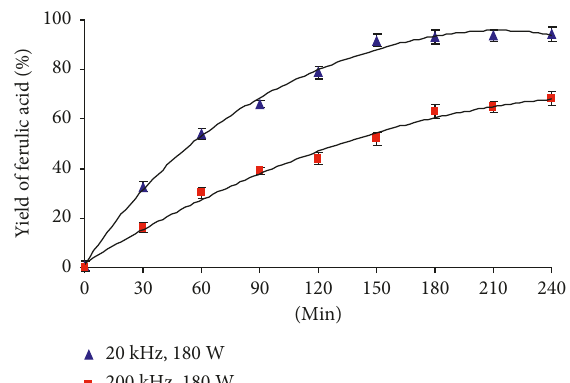
Figure 4: The yields of ferulic acid obtained by the ultrasound frequencies of 20 and 200kHz at power of 180W